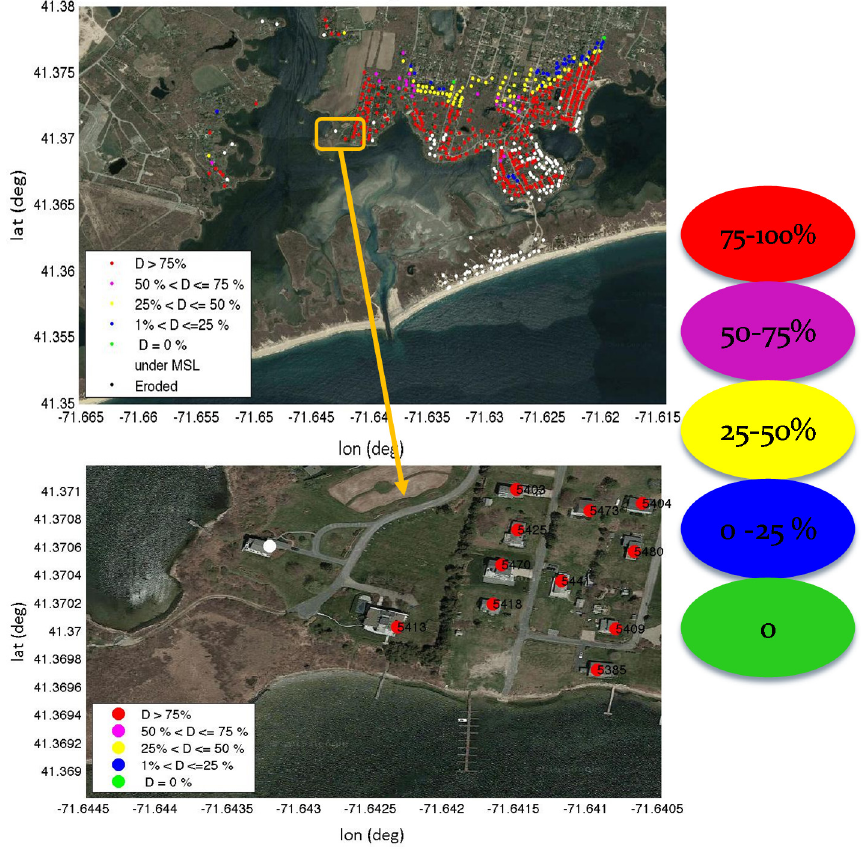
Figure A4. Percent damage by structure for Charlestown, RI for 100 year storm plus 2.1 m (7 feet) SLR, dunes eroded. Structures that are below MSL are noted by white dots and those removed by erosion are given by black dots. Progressively higher resolution maps of results (upper and lower panels). Individual structure IDs are noted at the highest resolution (lower panel). The yellow circle in the upper panel shows the location of the higher resolution area in the lower panel.